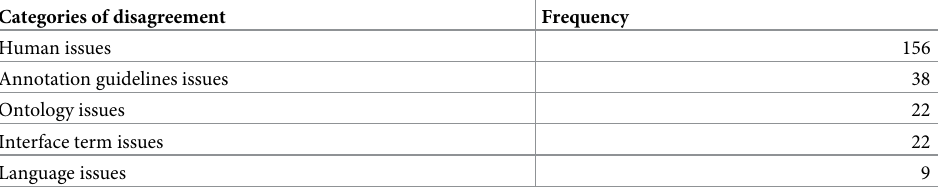
Table 5. Typology of disagreements and their